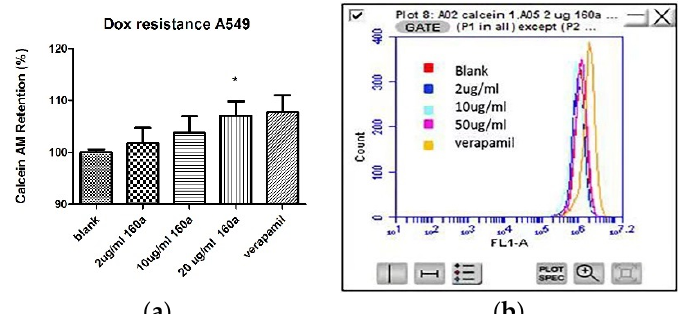
Figure 5. Effects of reversing the MDR phenotype in the doxorubicin-resistant A549 cell line. ( a ) Calcein acetoxymethyl (AM) retention produced by compound 160a on the doxorubicin-resistant A549 cell line; ( b ) the intensity of the green fluorescence signal from the calcein AM counted in the filter channel (FL-1) using a flow cytometric analysis of calcein AM with an increasing concentration of compound 160a (2, 10, and 20 μ g/mL). DMSO (0.1%) was applied as a vehicle control. Verapamil (50 μ g/mL) was applied as a positive control . n = 3. * p < 0.05, comparing with blank control group.